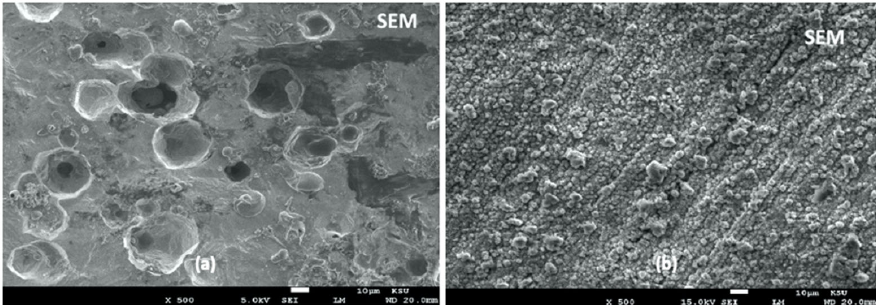
Figure 3. SEM surface analysis for the iron surface that was immersed in ( a ) 3.5% NaCl and ( b ) 3.5% NaCl + EH solutions for 48 h before measurement (Ahmed et al., 2021) [46].